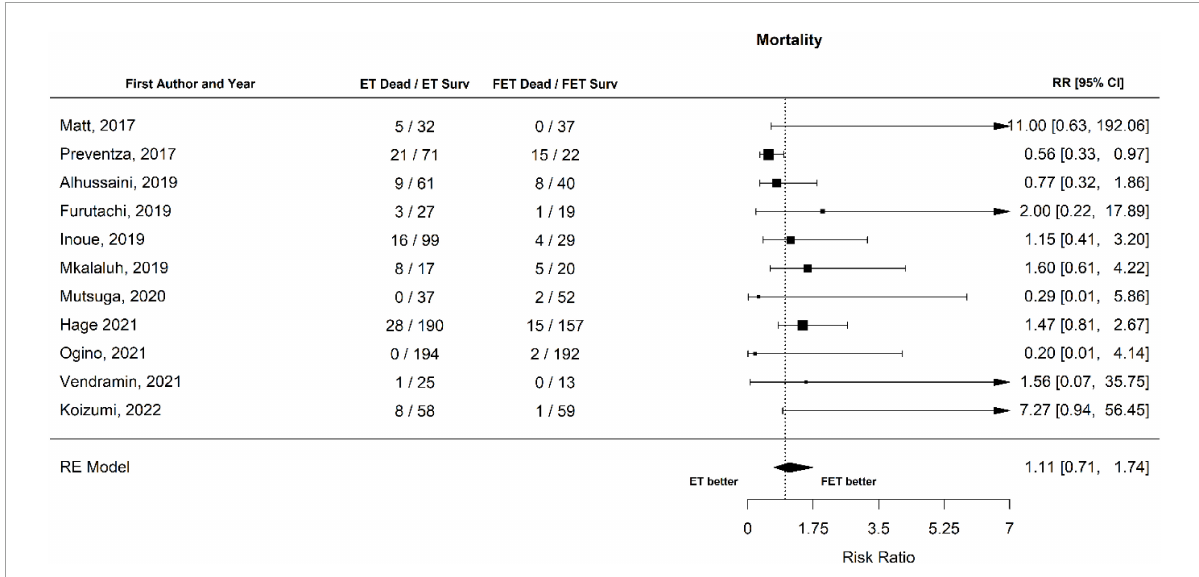
FIGURE10 Relative risk of mortality in patients undergoing aortic interventions with conventional elephant trunk (ET) vs. frozen elephant trunk (FET). Data only from studies published between 2017 and 2021. Forest plot p = 0.646.